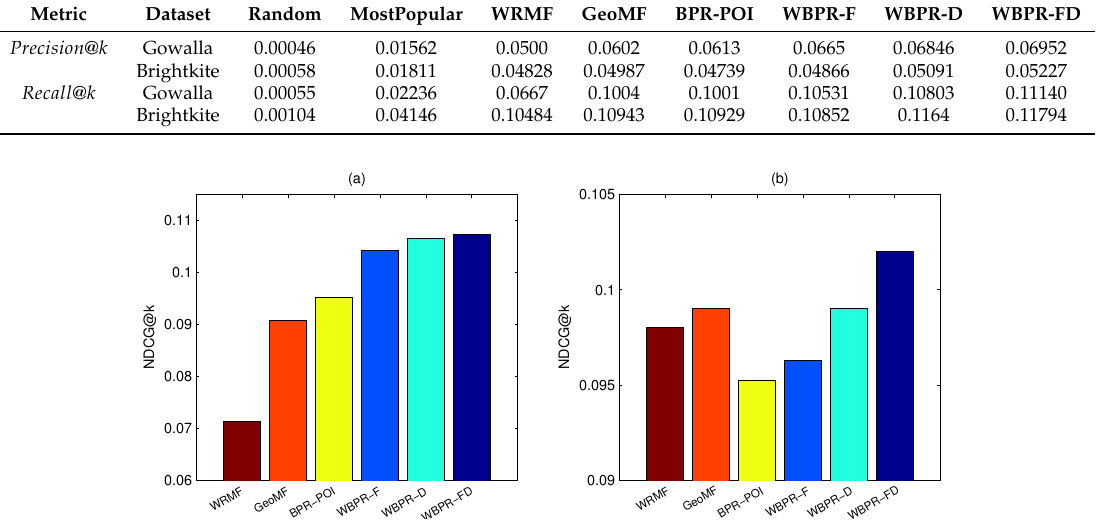
Figure 5. Performance comparisons with different training datasets in the metric of normalized discounted cumulative gain ( NDCG ) @ k (Dimensionality = 10, k = 5). ( a ) NDCG @ k in Gowalla; ( b ) NDCG @ k in